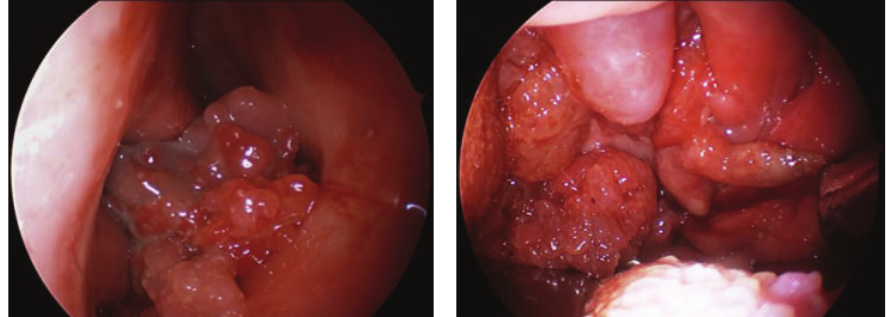
Figure 1: Fleshy papillary mass filling nasal cavity and oropharynx.